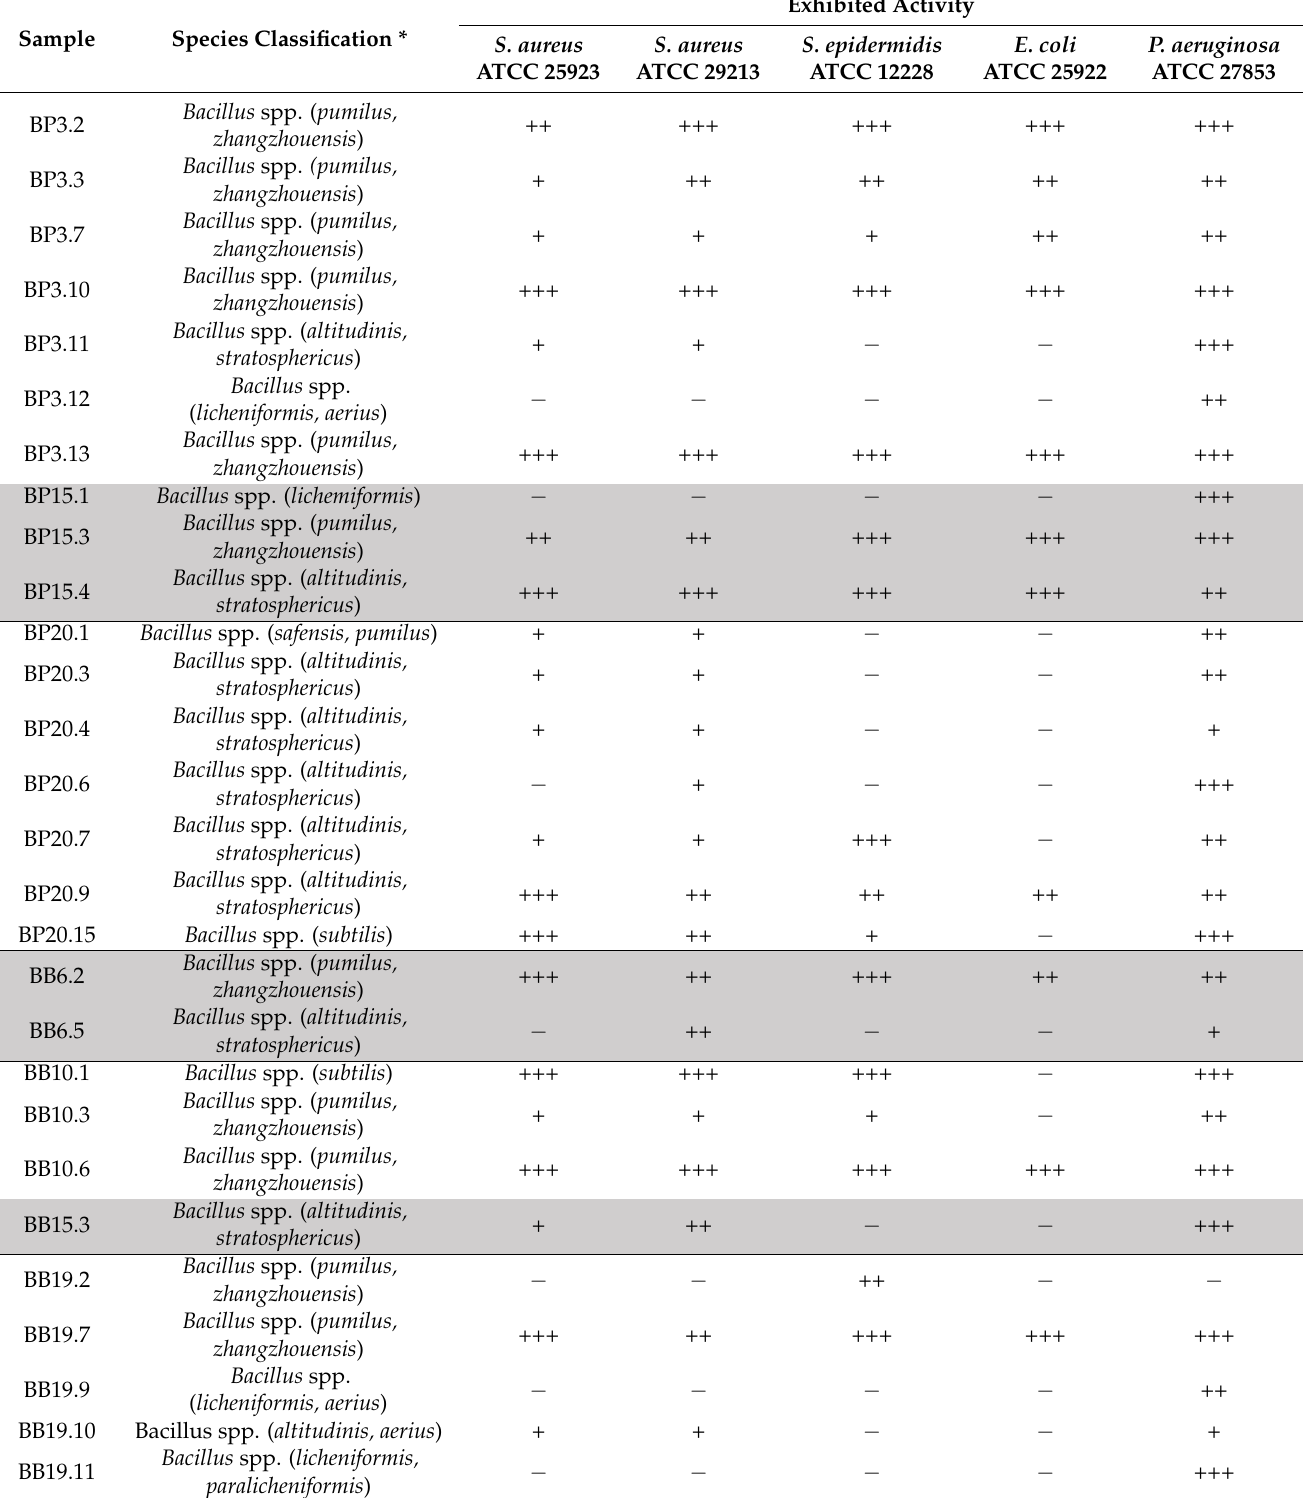
Table 2. Species classification based on the BLAST analysis of 16S rRNA gene sequences and antagonistic activity against reference strains of pathogenic